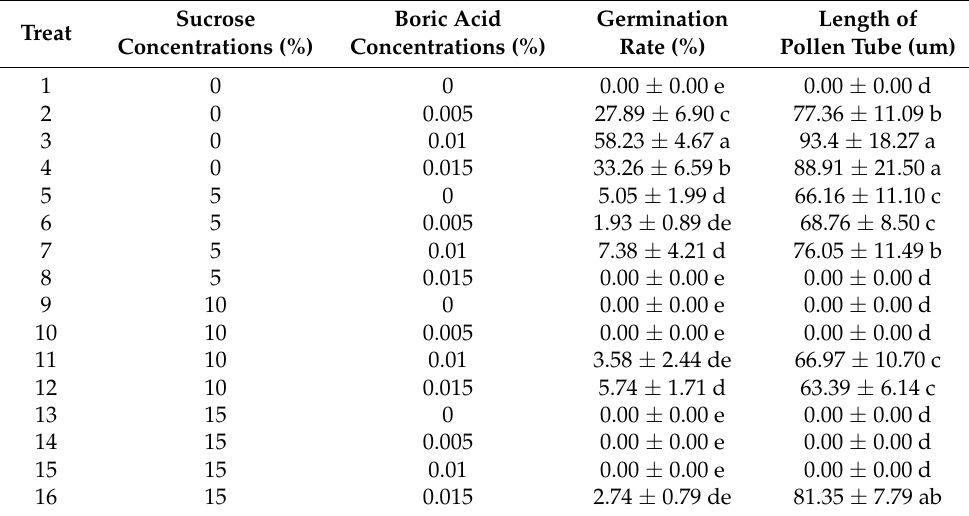
Data are mean ± SE. Different lowercase letters in each column indicate significant differences between different mass fraction of sucrose and boric acid ( p <